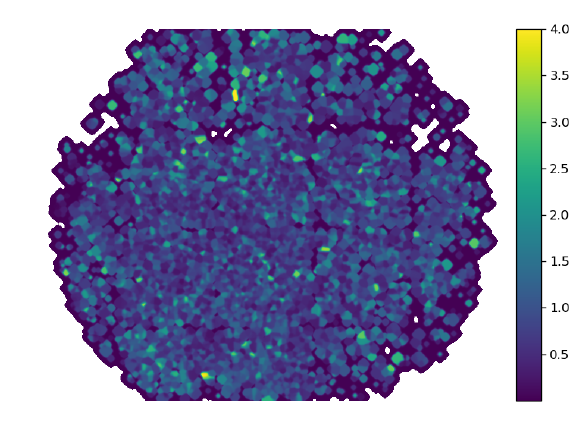
Figure 16. Distance map (in pixels) between the observed tie-point and the predicted tie-point by geometric model of